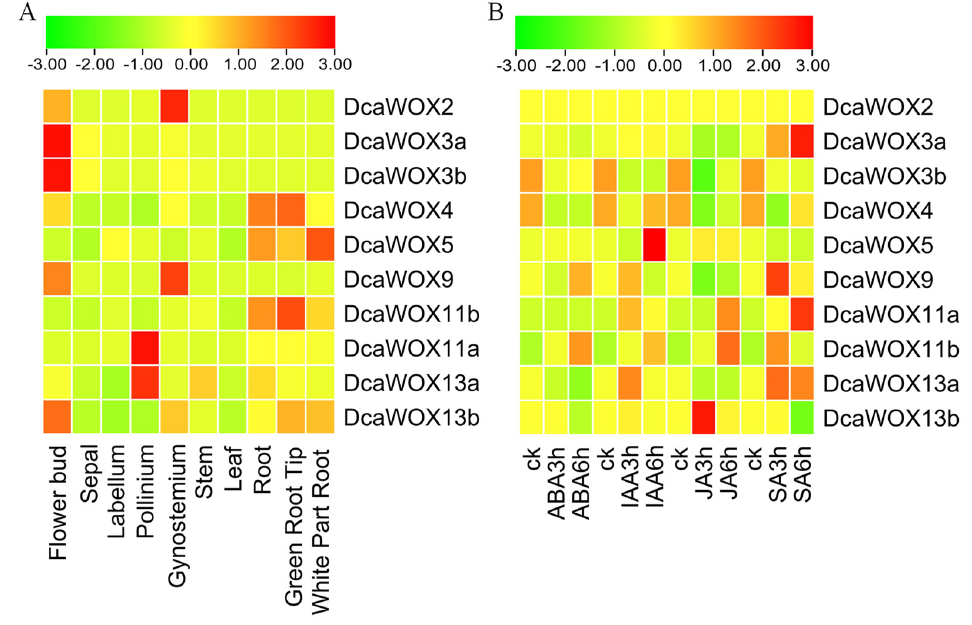
Figure 5. Expression profiles of D. catenatum WOX genes. ( A ) DcaWOX genes expression in different tissues. ( B ) DcaWOX genes expression after treatments with ABA, IAA, JA, and SA. ABA: abscisic acid; IAA: indole − 3 − acetic acid; JA: jasmonic acid; SA: salicylic acid; ck: control check; 3 h and 6 h: time-points after initiating the phytohormone treatments. ( n = 3).